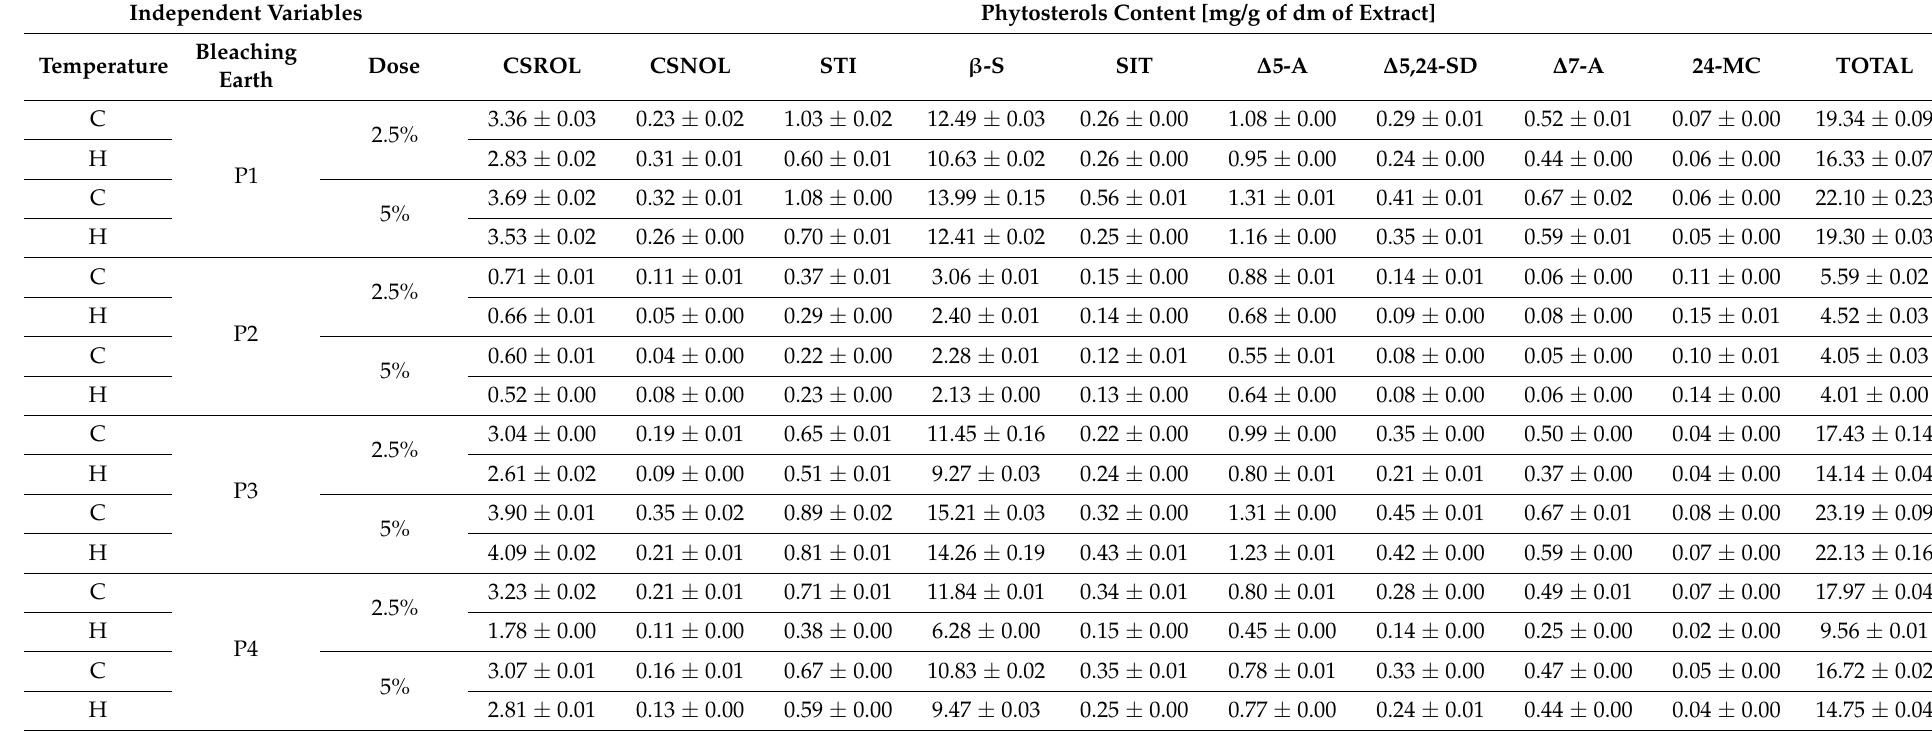
Table A1. The content of phytosterols in the poraffin extracts formed after washing bleaching earth with methanol bleaching earth after bleaching oil from the ‘S. Jubileu’ variety. Mean values based on n =